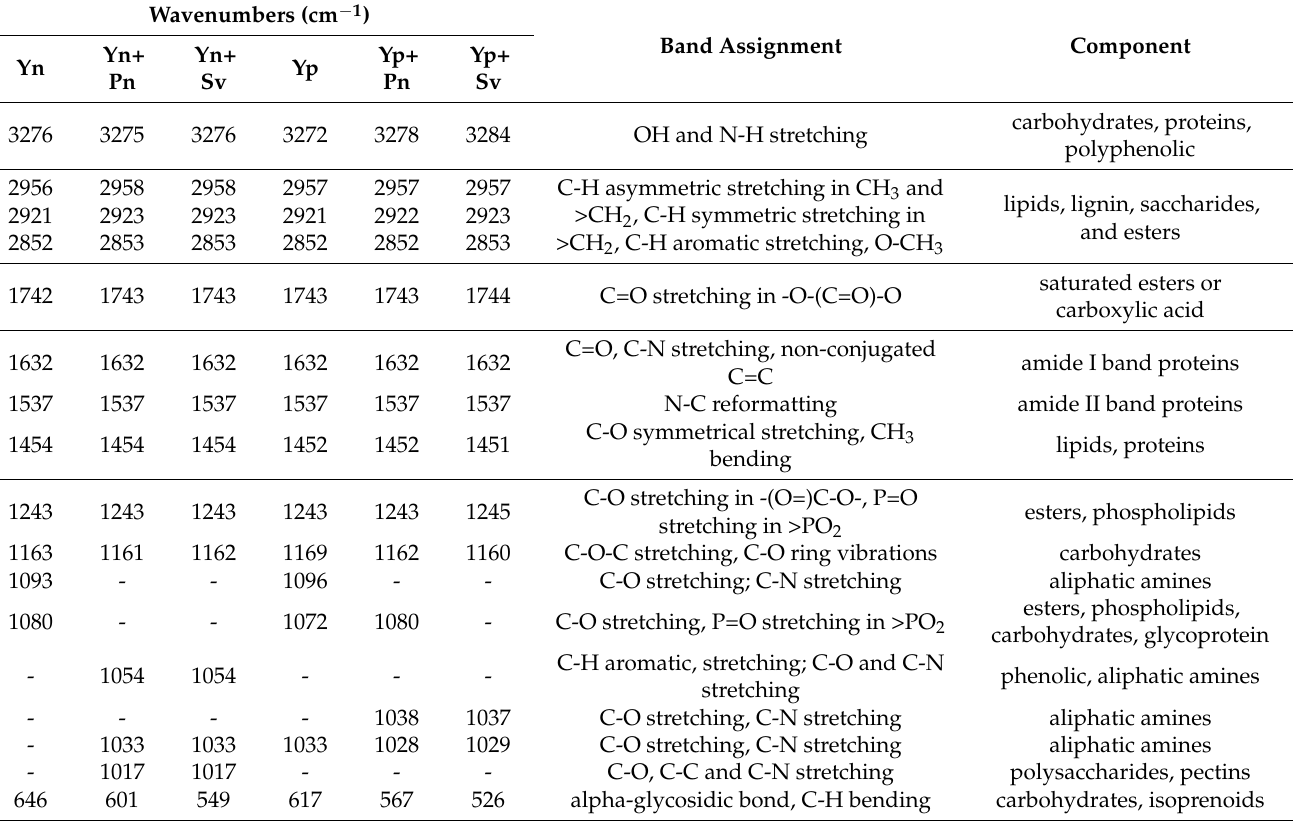
Table 5. Wavenumbers of QATR-FTIR peaks and functional groups of natural (Yn) and probiotic (Yp) yogurt with or without scCO 2 /H 2 O extracts from P. nigra (Pn) and S. viminalis